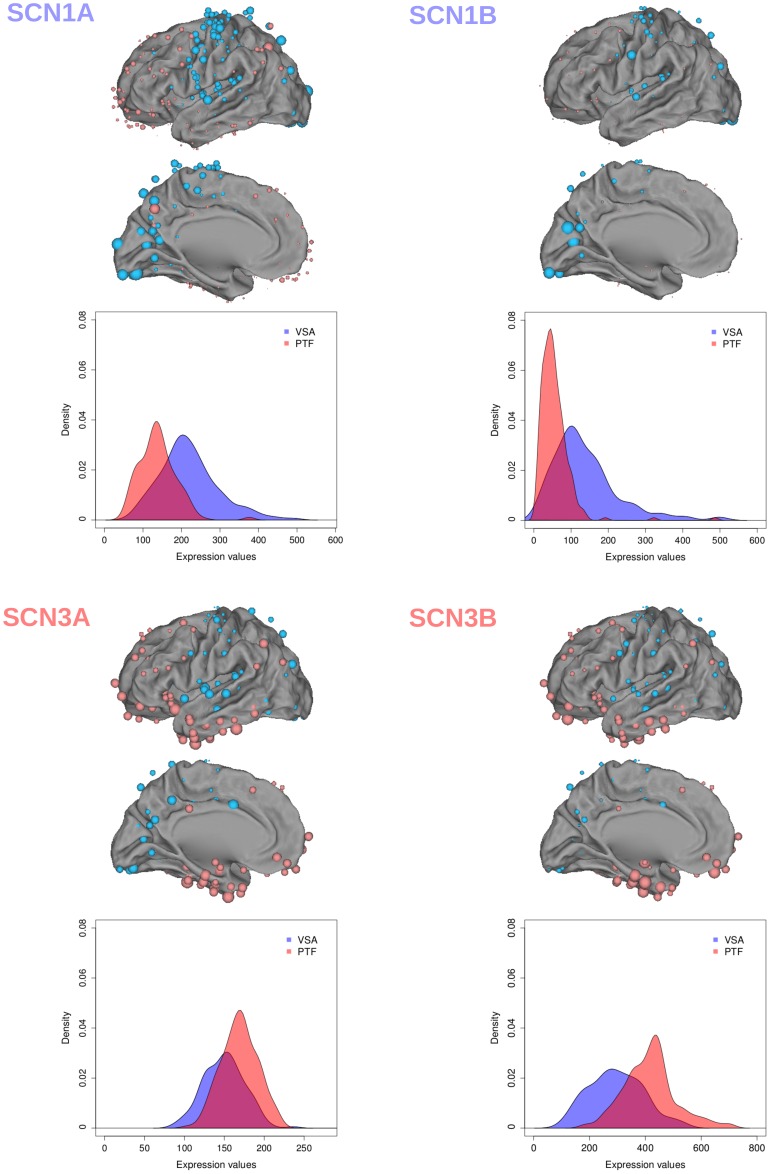
Example of cortical mapping of gene expression with extreme bootstrap ratios in PTF or VSA.Top. Cortical mapping of the expression of the 4 SCN genes with the highest bootstrap ratios in PTF or VSA: each dot represents one of the 394 cortical regions used in the analysis. The color depends upon the a priori assignment of each region the VSA-ring (in blue) to the PTF-ring (in red). The size of a dot is proportional to the expression of the gene under consideration for the cortical region represented by this dot. Bottom. For each gene, we plot the histogram of the number of regions as a function of gene expression intensities for the VSA (blue) and PTF (red) rings.